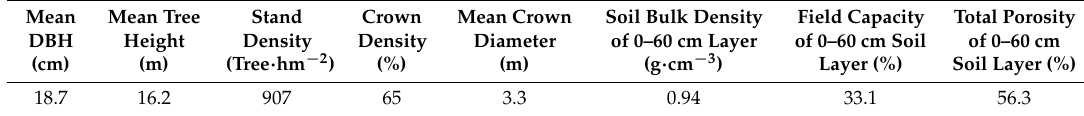
Table 1. The stand characteristics and site conditions of the Larix principis-rupprechtii plot. Diameter at breast height (DBH).